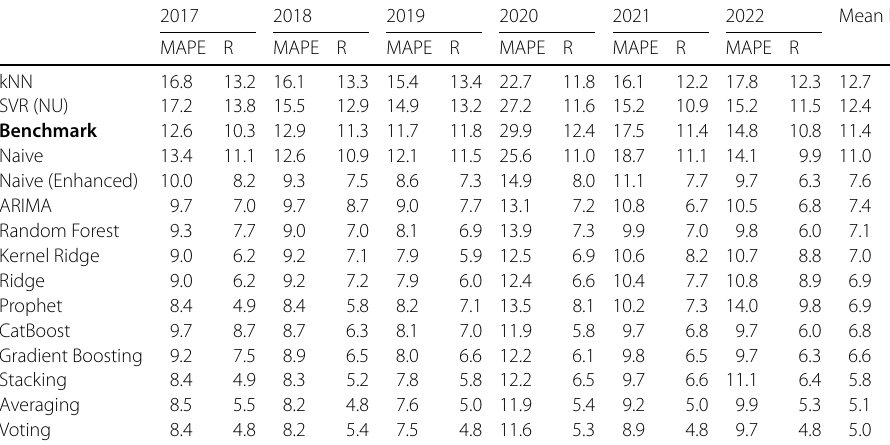
Table 5 Accuracies and mean ranks for all models across each year for Clinic 1